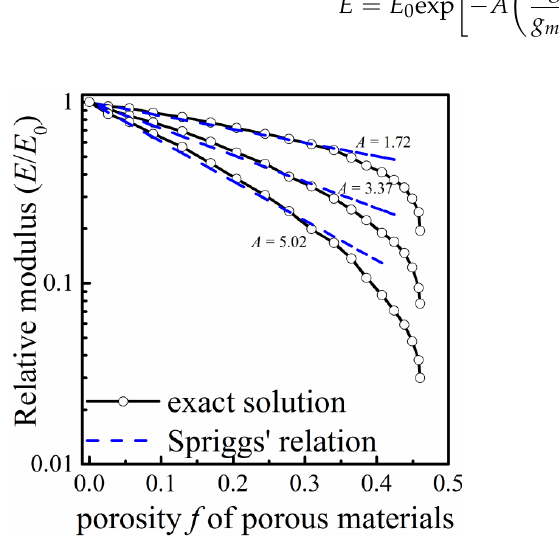
Figure 5. Elastic modulus of porous materials, reprinted/adapted with permission from Ref. [46] Wang 1984.